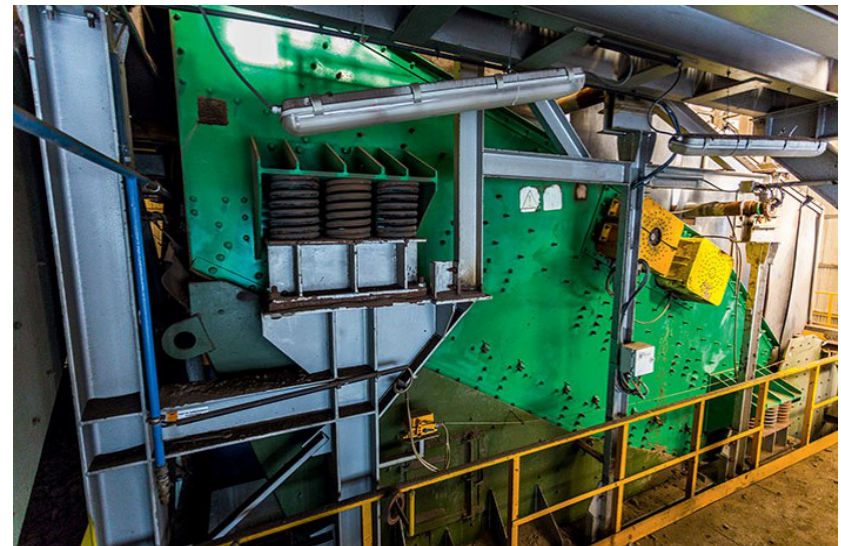
Figure 2. The vibrating